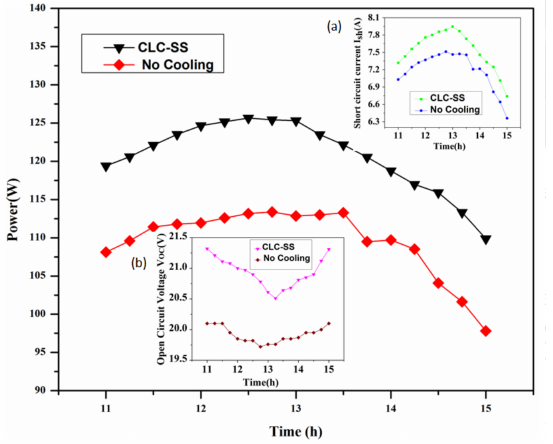
Figure 14. Comparative assessment of CLS-SS and conventional solar PV module with no cooling system.